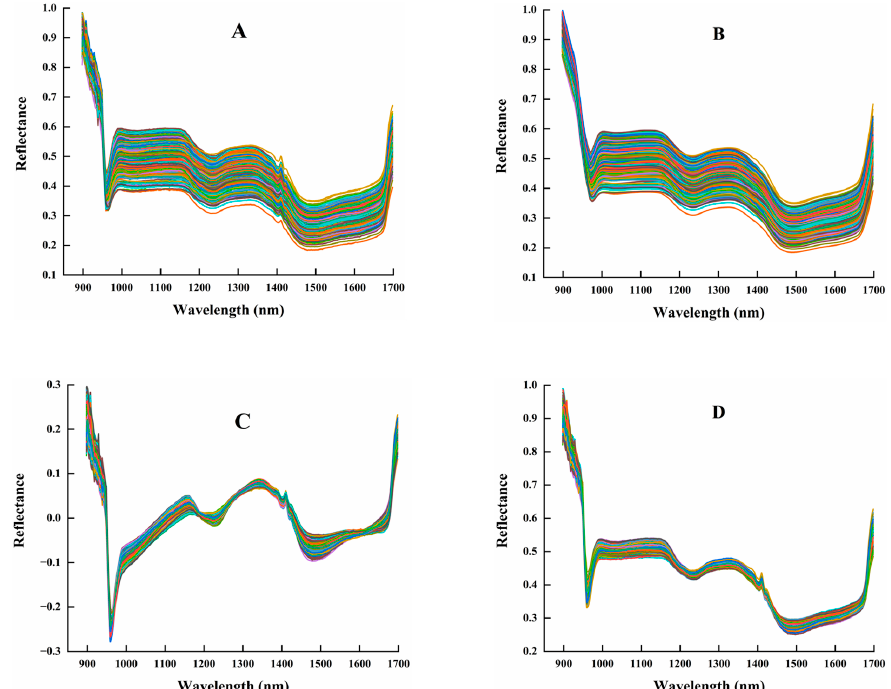
Figure 8. Spectral curves of maize seed samples under preprocessing conditions: ( A ) Raw; ( B ) SG; ( C ) DE; ( D ) MSC.